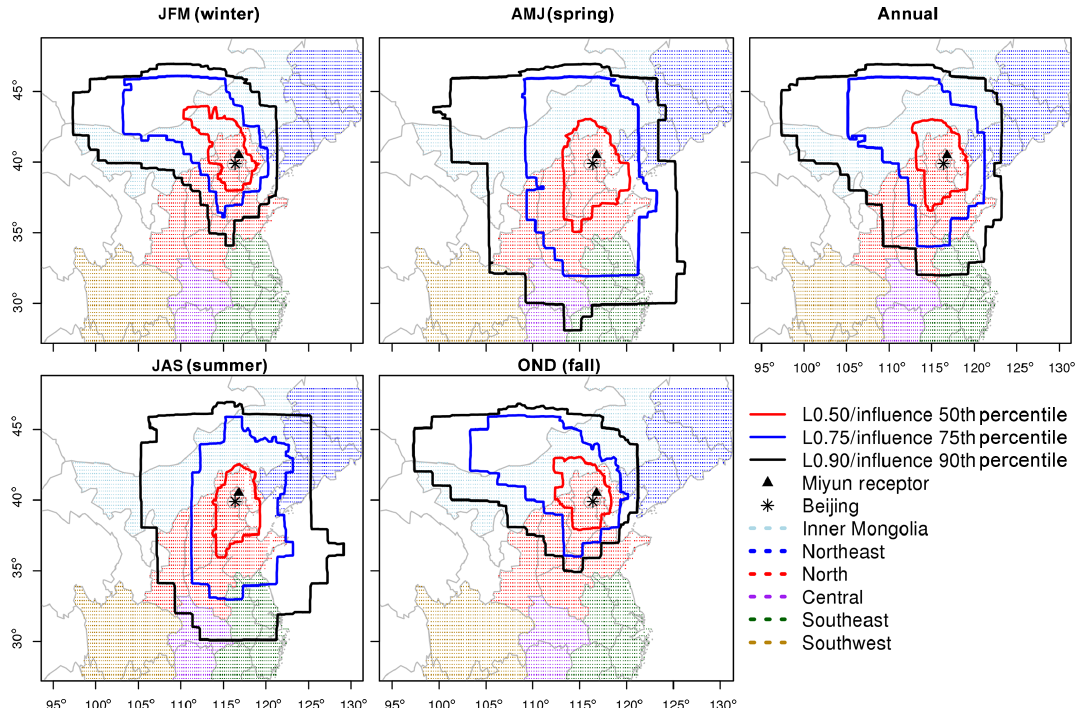
Figure 2. 2005–2009 mean seasonal (a–d) and Annual (e) footprint contours, as percentiles of influence highlighted by administrative region. Red, blue, and black contour lines represent 50th, 75th, and 90th percentile regions, respectively. Stippling represents location of 0 . 25 ◦ × 0 . 25 ◦ footprint and inventory grid cell centers, colored by relevant administrative regions. Northern China (red stippling) is the administrative region with predominant influence on Miyun observations, followed by Inner Mongolia and northeastern China. Southeastern and central China have minimal representation, and only during the spring and summer